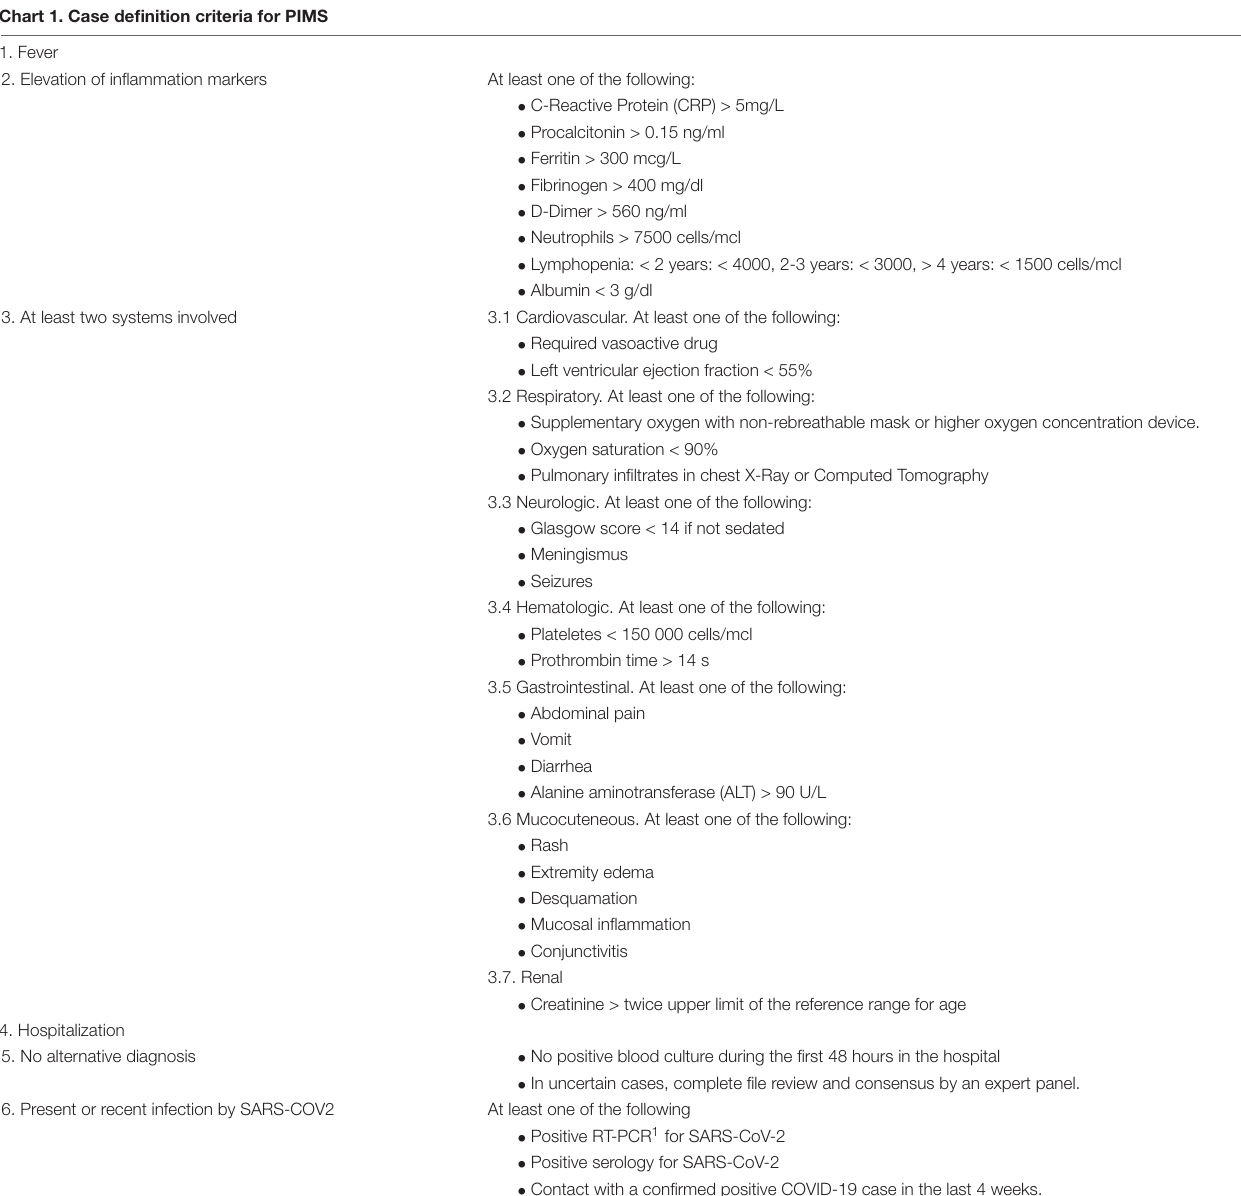
TABLE 1 | Case definition criteria for PIMS. Chart 1. Case definition criteria for